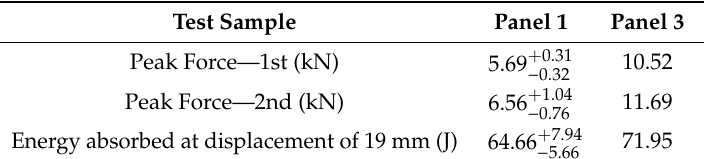
Table 4. Results of perimeter shear test.